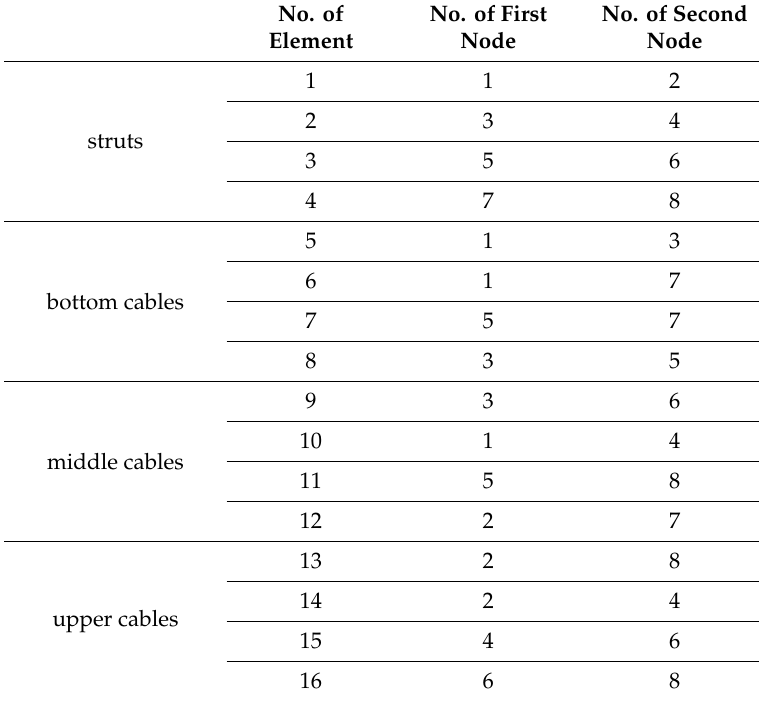
Table 3. Numbers of elements of the single modified Quartex module. No.